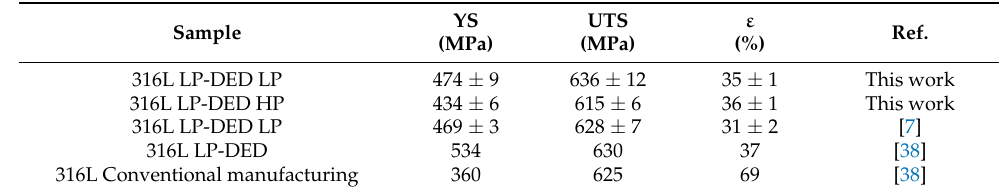
Figure 6. Representative tensile curves of DED 316L samples built with high power and low power parameters. Table 3. Tensile properties of DED 316L samples compared with literature data. Table 3. Tensile properties of DED 316L samples compared with literature data.